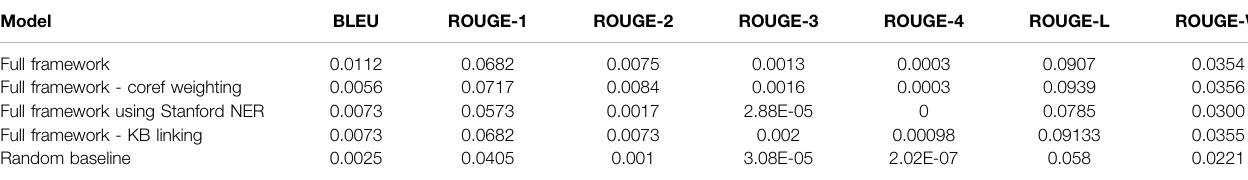
TABLE 2 | Automatic evaluation of text relatedness.